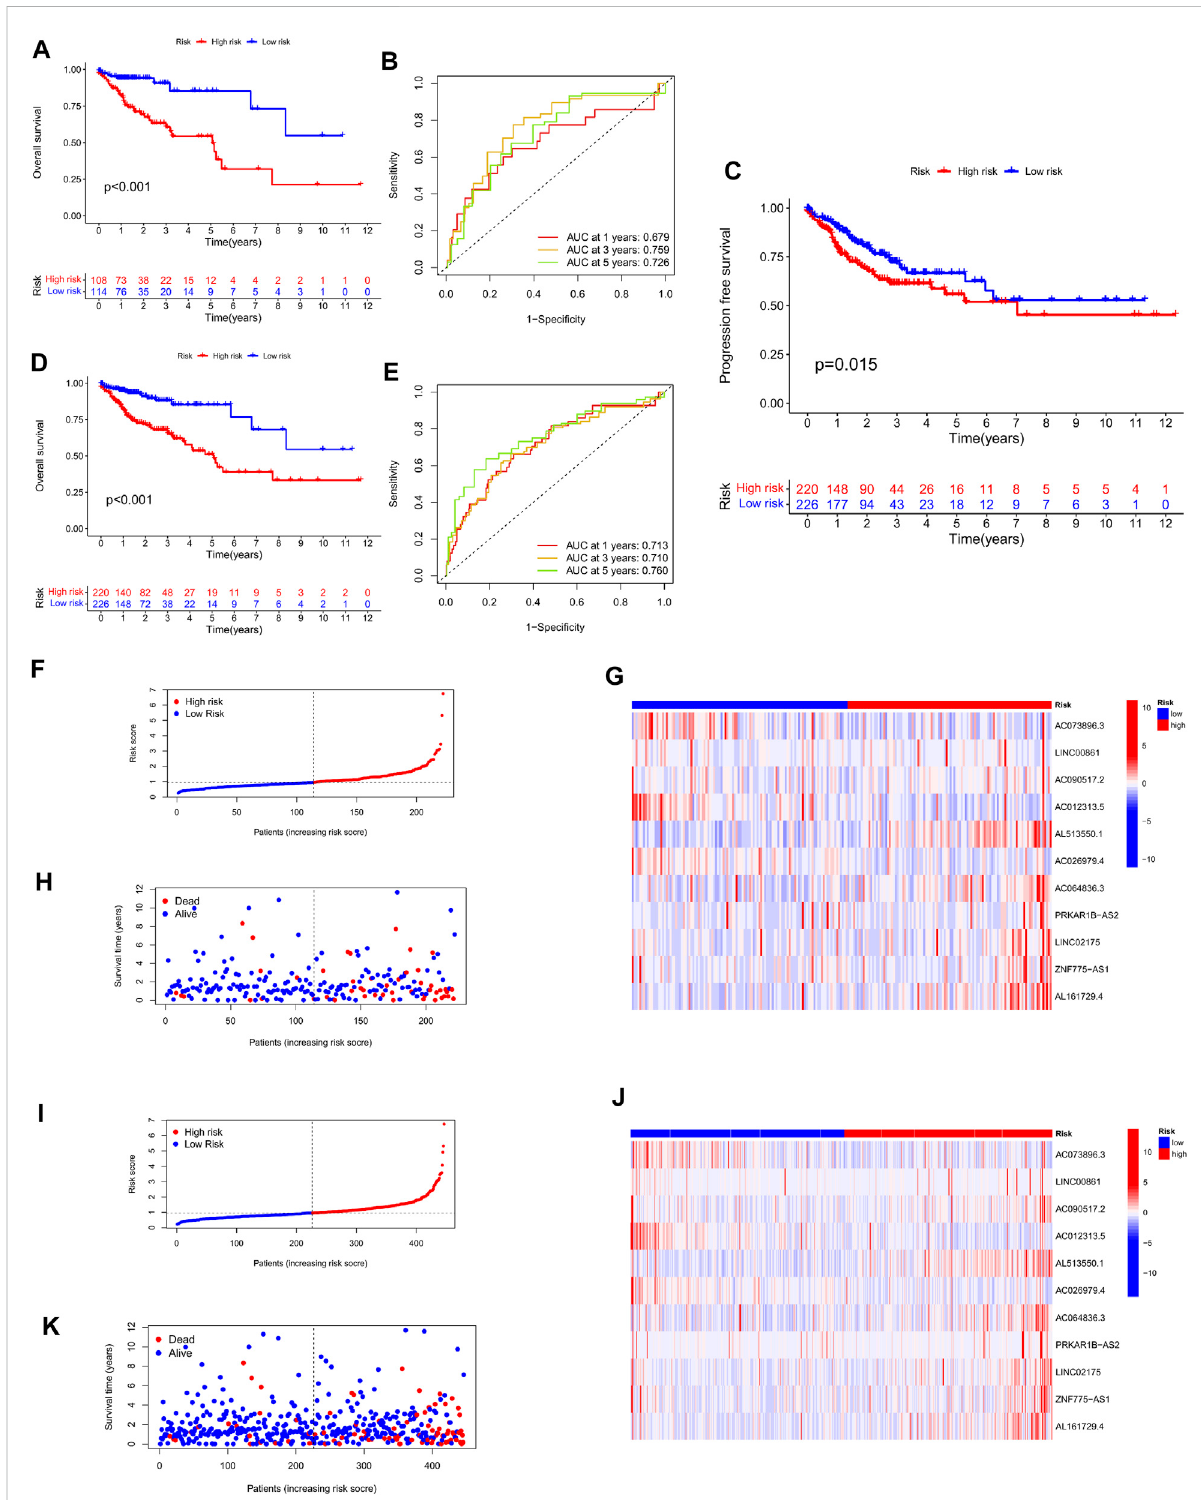
FIGURE 5 Validationofthestabilityoftheriskscoringmodelinthetestcohortandthetotalcohort. (A,B) Survivalcurvesofhigh-andlow-riskgroupsinthe test cohort, and ROC curvesand AUC values of the model at 1, 3, and 5 years. (C) Progression-free survival curves of patients in the high and low risk groupsinthetotalcohort. (D – E) Survivalcurvesofhigh-andlow-riskgroupsinthetotalcohort,andROCcurvesandAUCvaluesofthemodelat1,3, and5years. (F – H) Scatterplotsand heatmapsofexpressionlevels ofcharacteristiclncRNAsforpatientriskscoreassessmentinthetestcohort. (I – K) Scatter plots and heatmaps of expression of characteristic lncRNAs for patient risk score assessment in the test